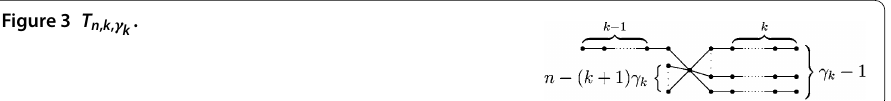
Figure 3 T n , k , γ